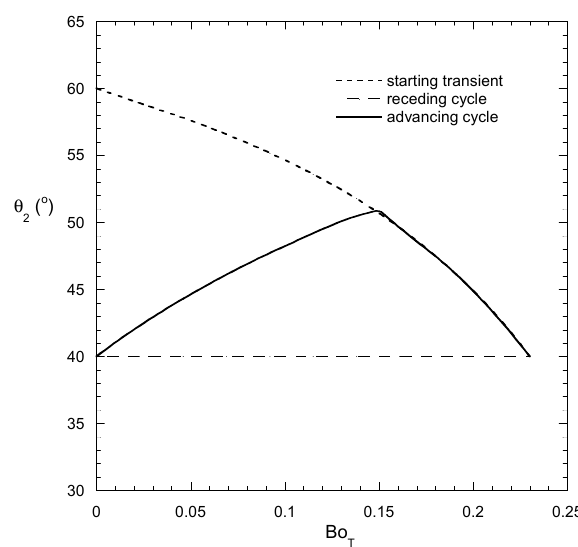
Figure 5. Evolution of droplet front angle θ 2 with Bo T for Bo N = 12 Bo T and periodic forcing (V A = 5 mm 2 , θ a = 60°, θ r = 40°, θ ο = 60°).